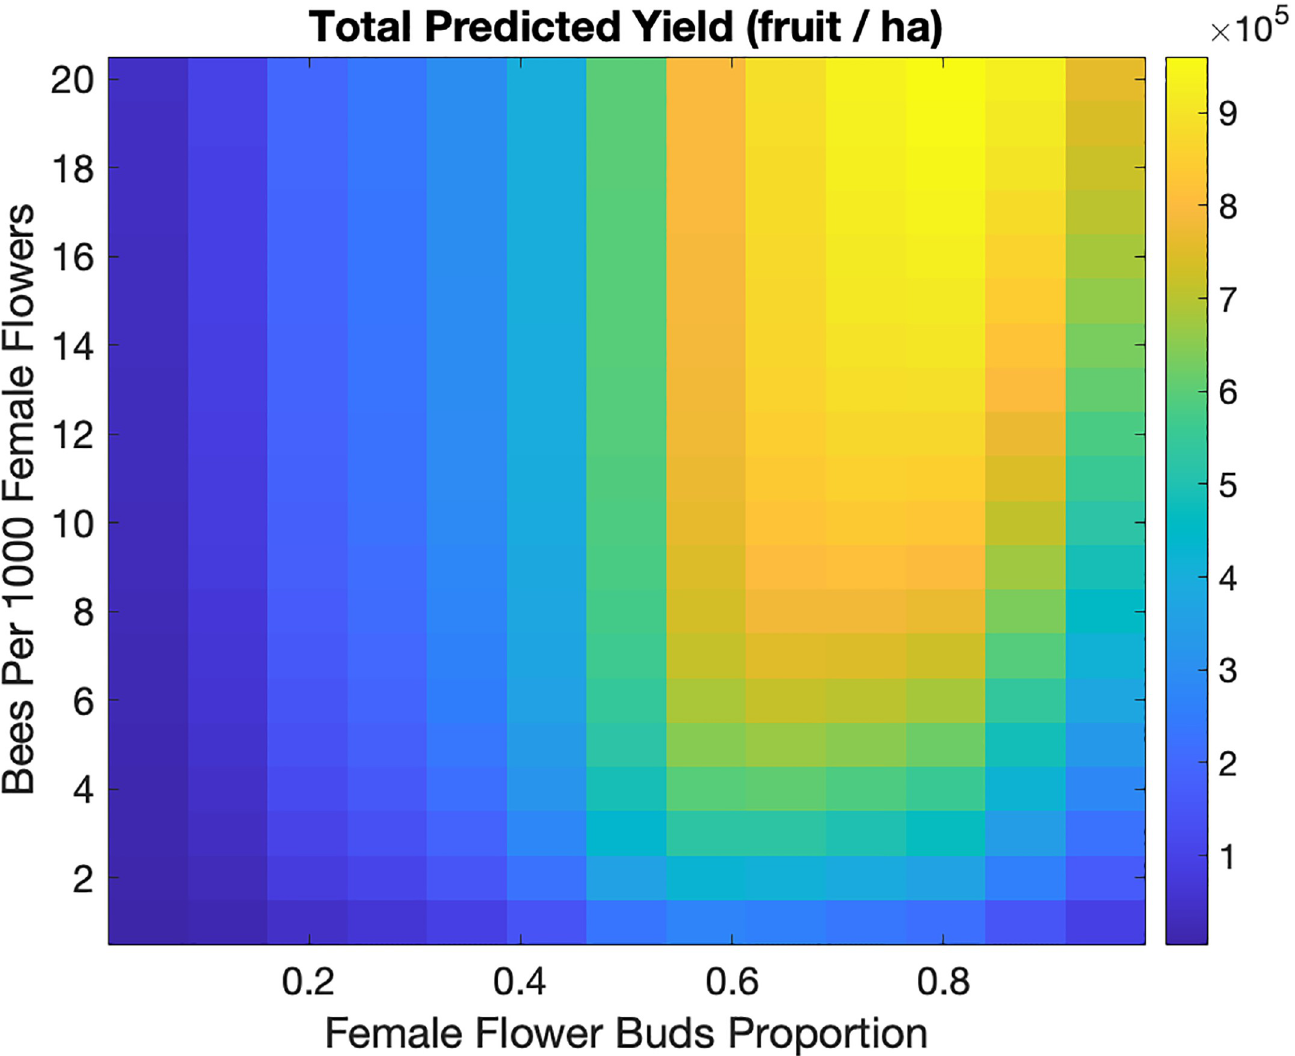
Fig 9. Total predicted yield for varying the proportion of female flower buds and the number of bees per 1000 female flowers. The total amount of buds was kept constant at 1.2 million/ha. Other parameters are baseline values in Table